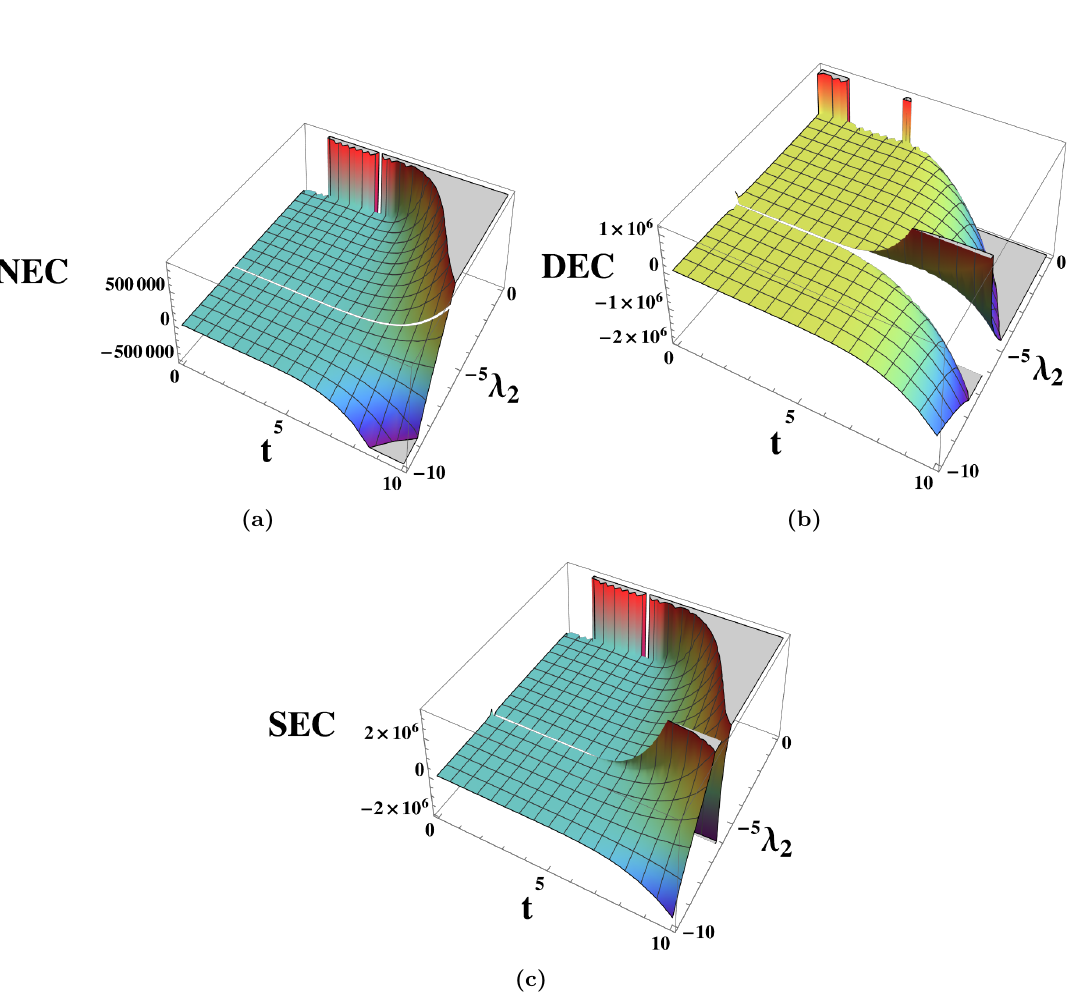
Figure 5. Behaviors of NEC, DEC and SEC for n = 2 . 15